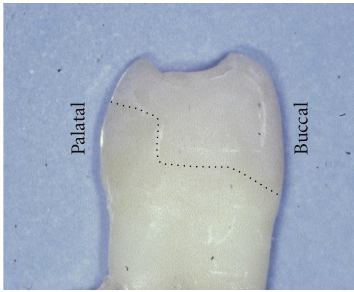
Figure 1: Upper premolar with original cusp-replacing resin composite restoration with FRC basing. Dotted line indicates cavity surface and position of fiber layer.